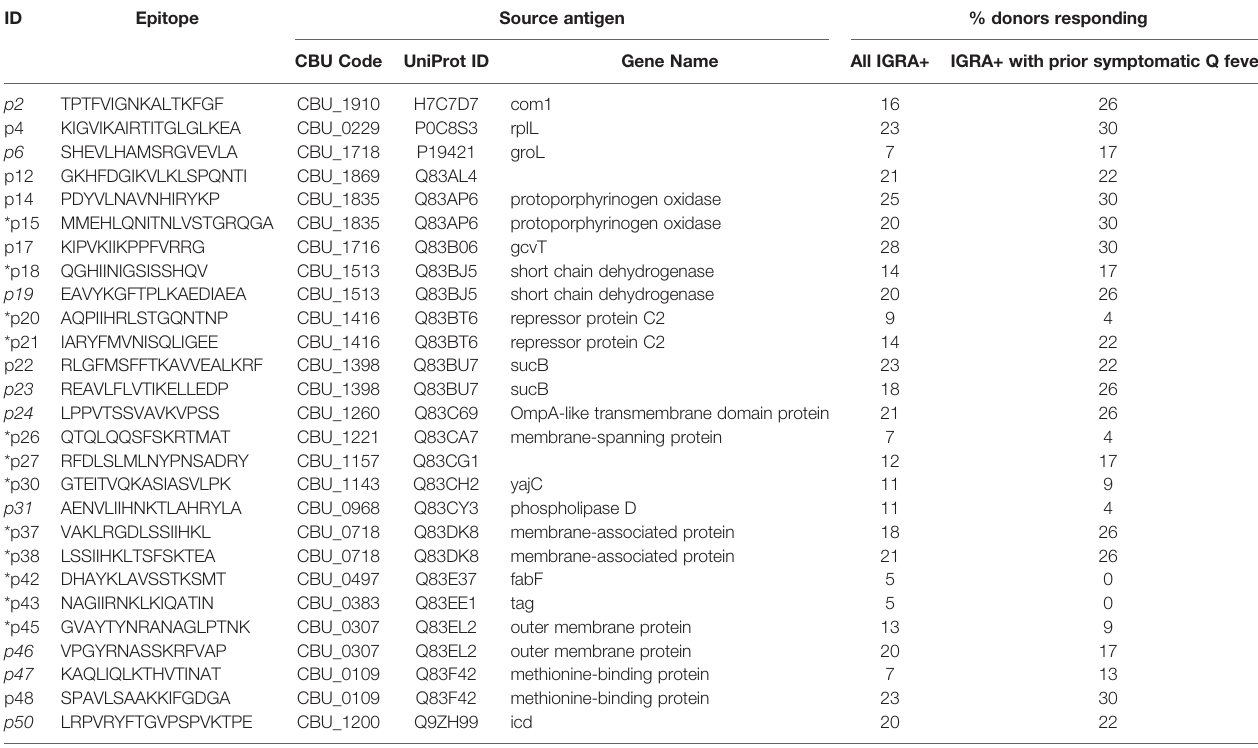
TABLE 4 | HLA class II epitopes selected for vaccine